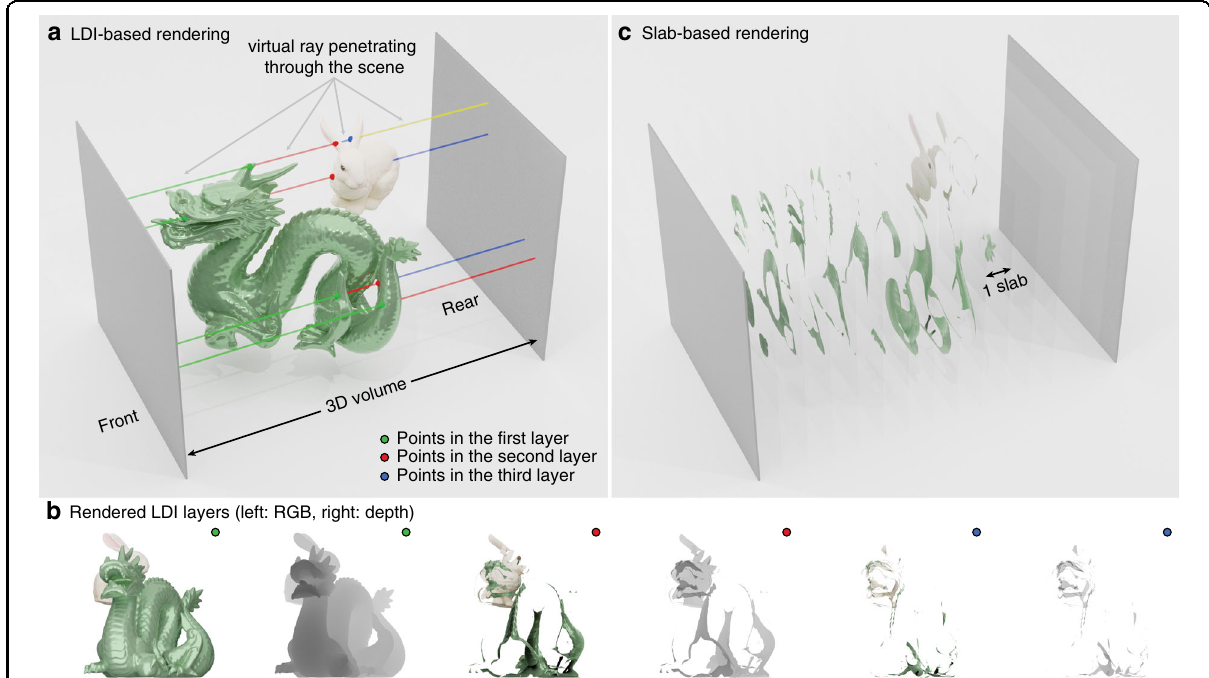
Fig. 1 Comparison of LDI and voxel grid as 3D scene representation. a Rendering of an LDI records the intersections between a penetrating ray (colored differently after every new hit) and the scene objects (front-facing surfaces) at every spatial location. b First three layers of the LDI rendered for the scene in a . The number of valid pixels rapidly decreases as the index of the layer increases. c Rendering of a voxel grid that partitions the 3D scene into equal-length slabs and generates one RGB image for each slab. The depth resolution is proportional to the number of